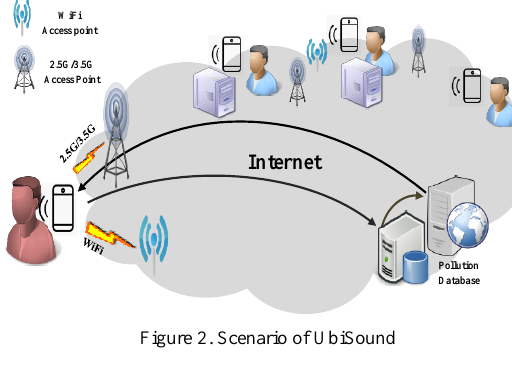
Figure 2. Scenario of